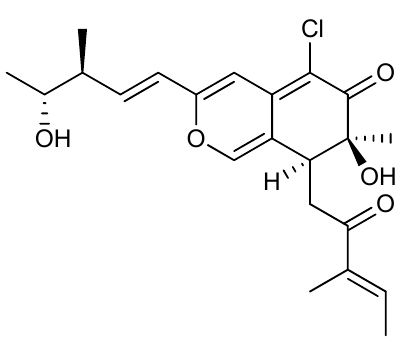
Figure 5. 11-Epichaetomugilin I.